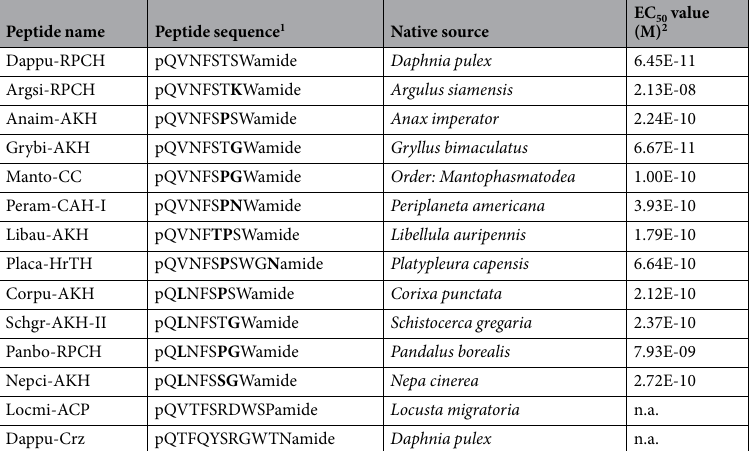
Table 1. AKH/RPCH and related peptides tested on the putative Daphnia pulex RPCH receptor in in vitro bioluminescence assays. Abbreviations used: RPCH, red pigment concentrating hormone; AKH, adipokinetic hormone; CC, corpora cardiaca ; CAH, cardioacceleratory hormone; HrTH, hypertrehalosaemic hormone; ACP, adipokinetic/corazonin-related peptide and Crz, corazonin; n.a., not applicable. 1 Amino acid residues in bold text indicate a substitution in RPCH/AKH sequences relative to Dappu-RPCH. 2 EC 50 values were calculated from dose-response curves in the current